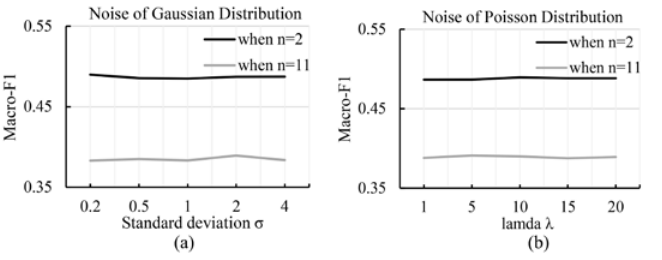
Figure 5. Perturbation analysis: The steady Macro-F1 results show that PEM could handle the problem with high noise 4. CASE STUDY: URBAN STRUCTURE IN SHANGHAI (CHINA) USING TAXI TRAJECTORY